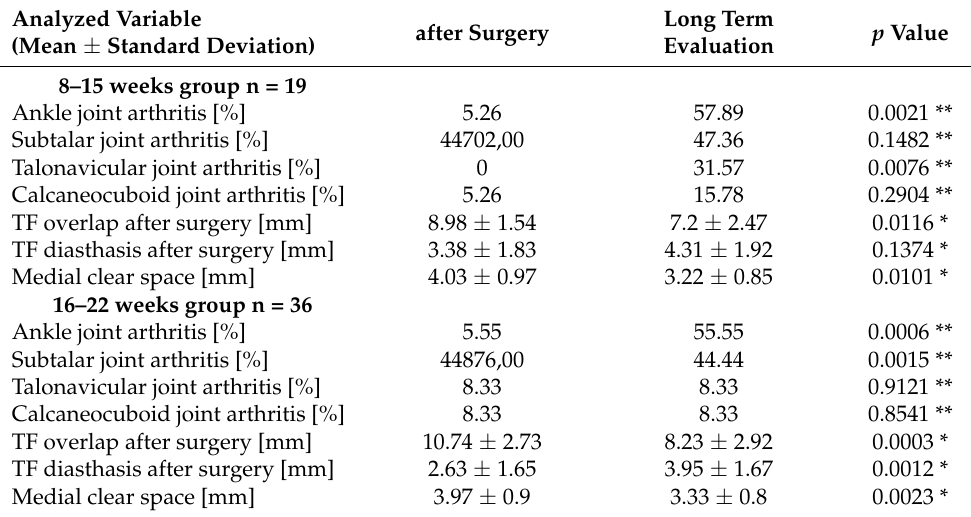
Table 4. Detailed radiological assessment of patients after surgery and in last control visit in the 8–15 weeks group and 16–22 weeks